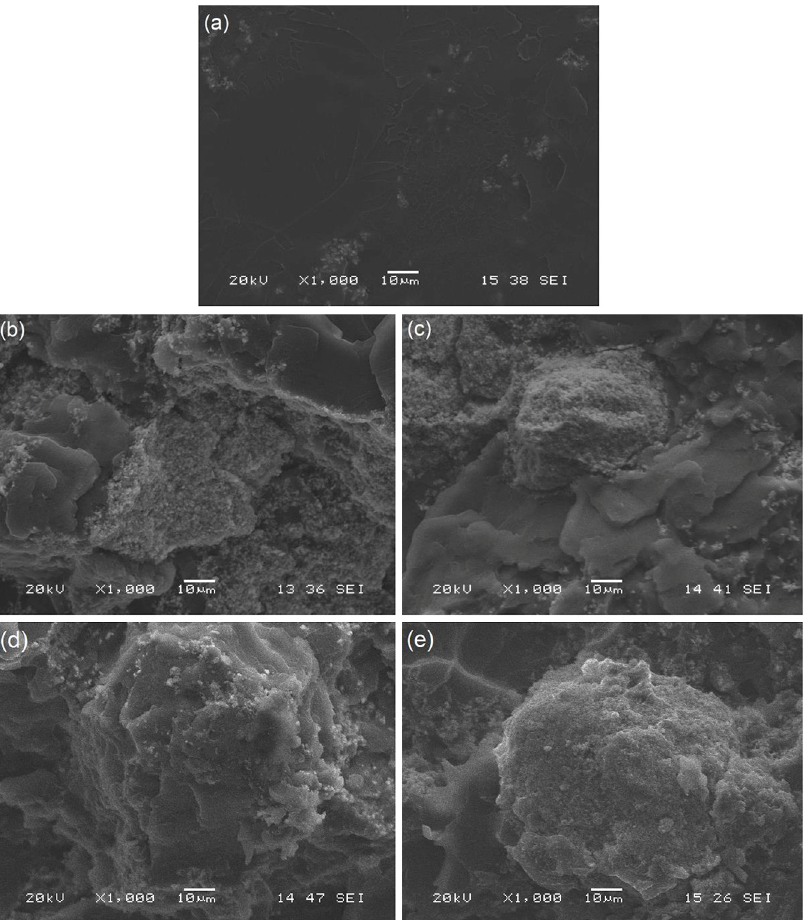
Figure 8. SEM micrographs of the bending fracture surfaces on the transition band at x1000 magnification of the ( a ) reference bone cement and the bone cements prepared with 15 wt % of structured nanoparticles ( b ) 20/80, ( c ) 30/70, ( d ) 40/60, and ( e ) 50/50.